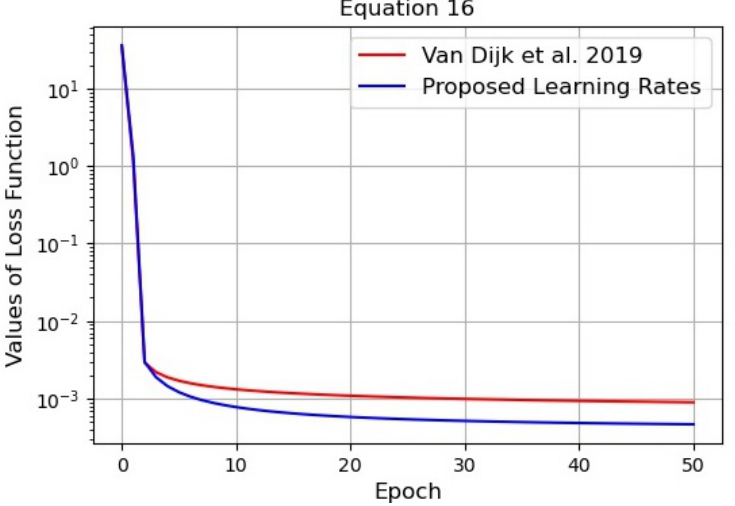
Figure 2. Values of loss function and convergence rate for w-convex binary problem (Equation (16))